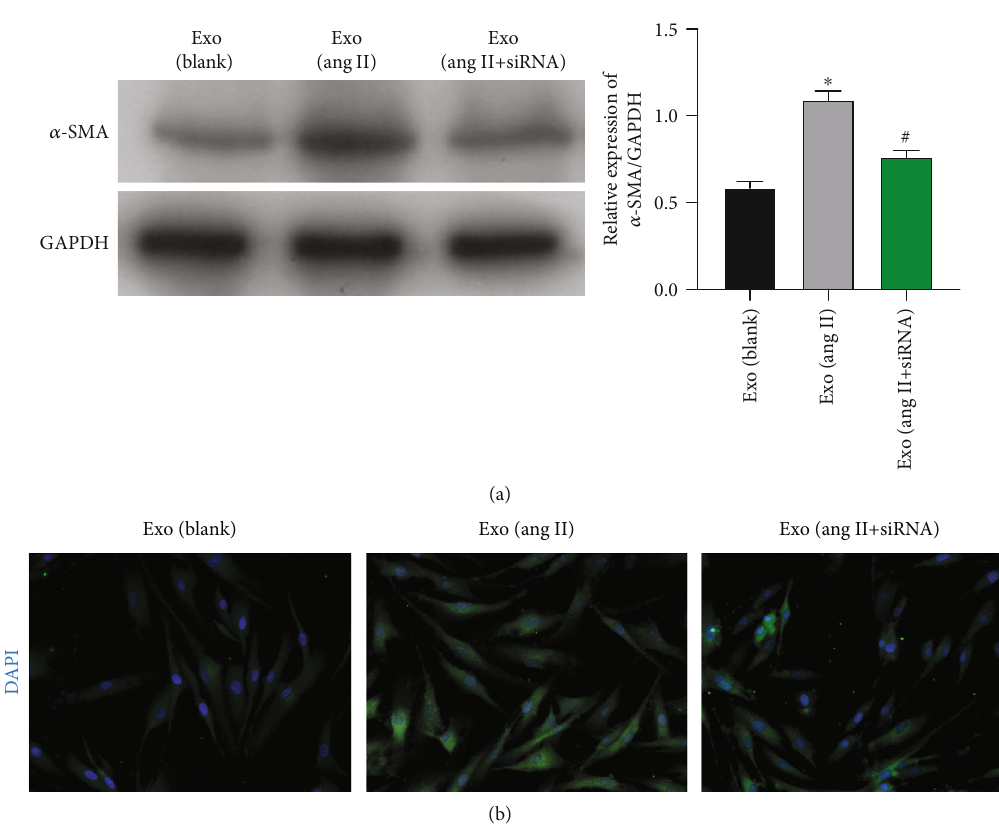
Figure 10: Exosomes from HSCs transfected with ASK1 siRNA showed lower levels of α -SMA expression. Western blot (a) and immuno fl uorescence assays (b) were used to measure α -SMA expression in HSCs that had been incubated with exosomes from blank HSCs, Ang II-treated HSCs, and Ang II+siRNA-treated HSCs, respectively. ∗ p < 0 : 05 vs. blank; # p < 0 : 05 vs. Ang